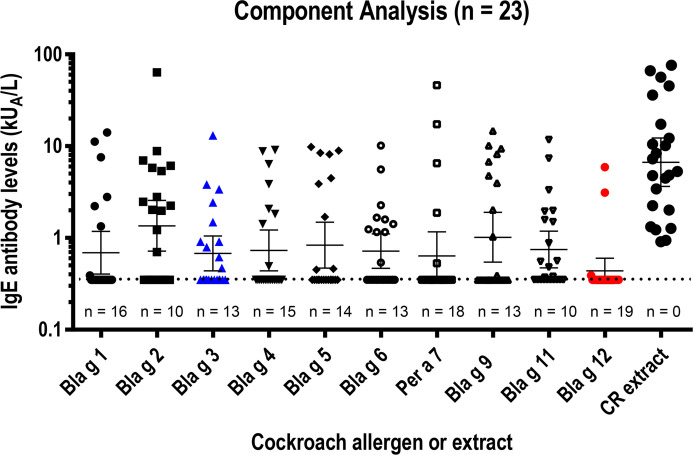
IgE reactivity to 10 cockroach allergens and cockroach extract in a USA cohort (n = 23). Long and short horizontal lines indicate geometric means and 95% CIs, respectively. The cut-off level for IgE quantification (0.35 kUA/L) is indicated by the horizontal dotted line. The number of negative results (< 0.35 kUA/L) is provided for each allergen under the corresponding cluster of symbols. Data obtained with Bla g 3 (blue) and Bla g 12 (red) -measured in an equivalent manner to the values previously reported for the other allergens and the same cohort (4)- were inserted in a plot showing IgE to the other eight allergens (black). IgE levels to the 10 allergens were combined in one plot to facilitate their visual comparison, because IgE levels are consistent for the same sera (properly stored at -20˚C) when measured in different occasions by ImmunoCAP, which has a high allergen capacity (several micrograms per CAP).